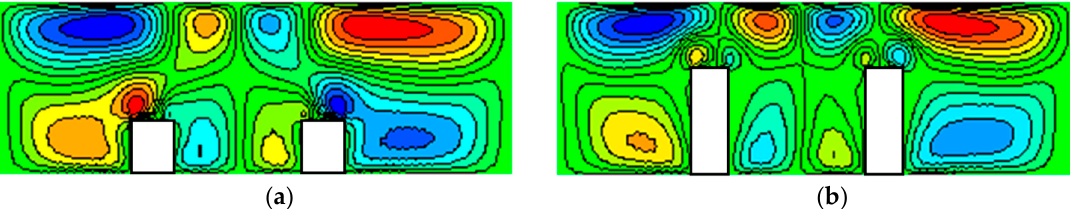
L 1 = L 2 = 0.9, ( | ψ | max = 2.5927 ) . Appl. Sci. 2019 , 9 , 2673 0.6 , (|ψ| (cid:2923)(cid:2911)(cid:2934) = 2.7263) ; ( f ) 𝐿 (cid:2869) = 𝐿 (cid:2870) = 0.9, (| ψ | max = 2.5927 ) .